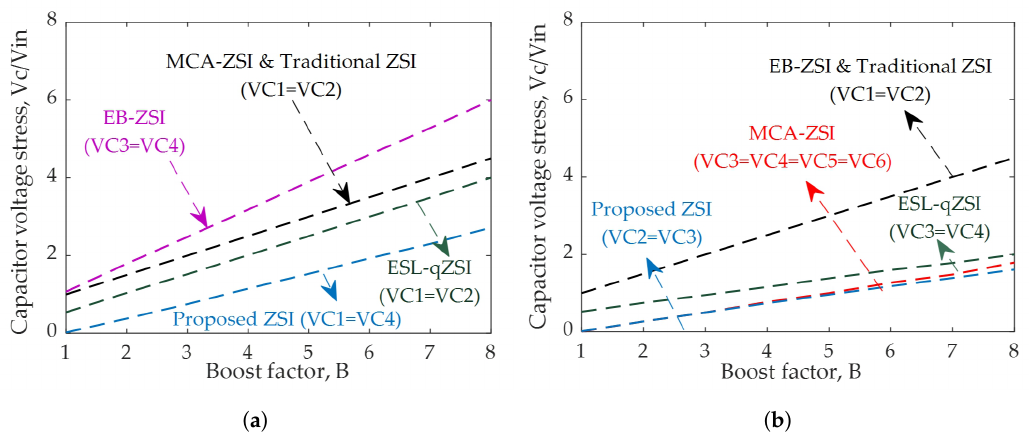
Figure 8. Characteristics curve: ( a ) high stressed capacitor and ( b ) low stressed capacitor. Table 1. Parameters associated with the performance of the switched inductor assisted strong boost Z-source inverter (SL-SBZSI) and modified capacitor assisted Z-source inverter (MCA-ZSI) for the same D S and V